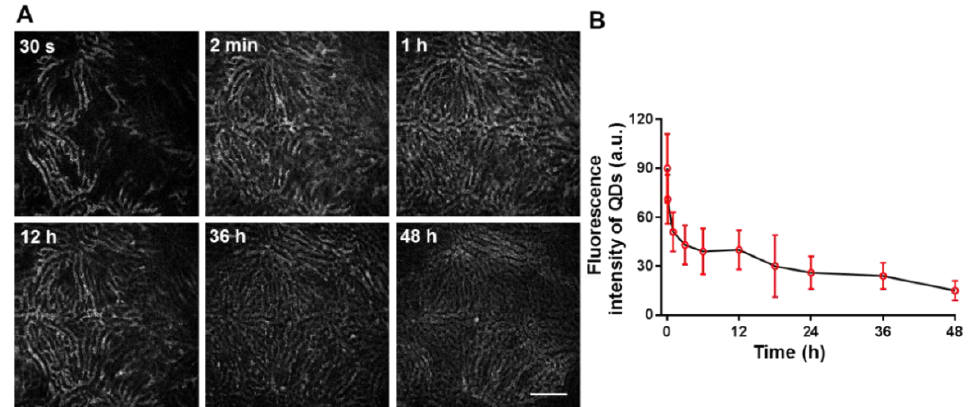
Figure 4. Time profile of QDs intensity in vasculature of normal liver after bolus injection. ( A ) Real-time hepatic disposition of QDs, (Scale bar: 160 μm); ( B ) Time profile of QDs intensity per pixel. The symbols represent measured data and the line represents the connecting curve. Error bar represents the standard deviation ( n = 3).